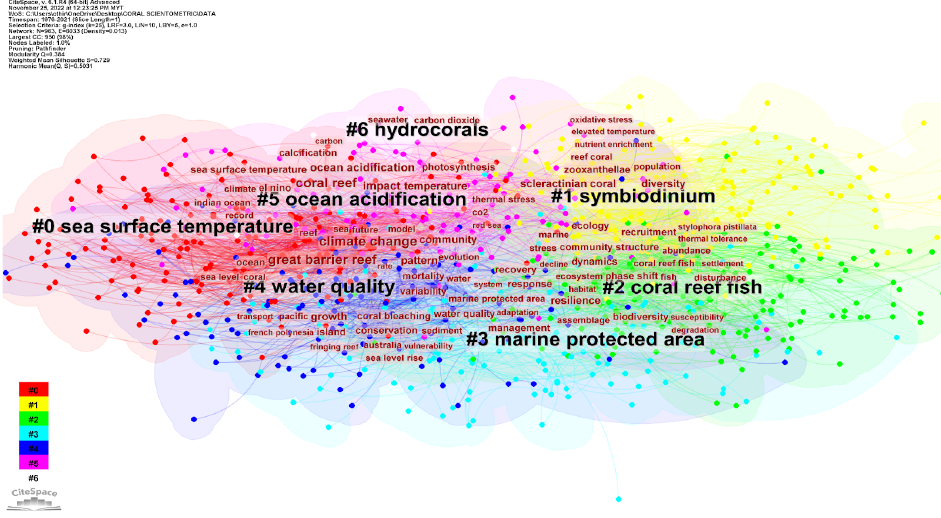
Figure 9. Distribution of co ‐ cited keywords in the field of coral reef and climate change.